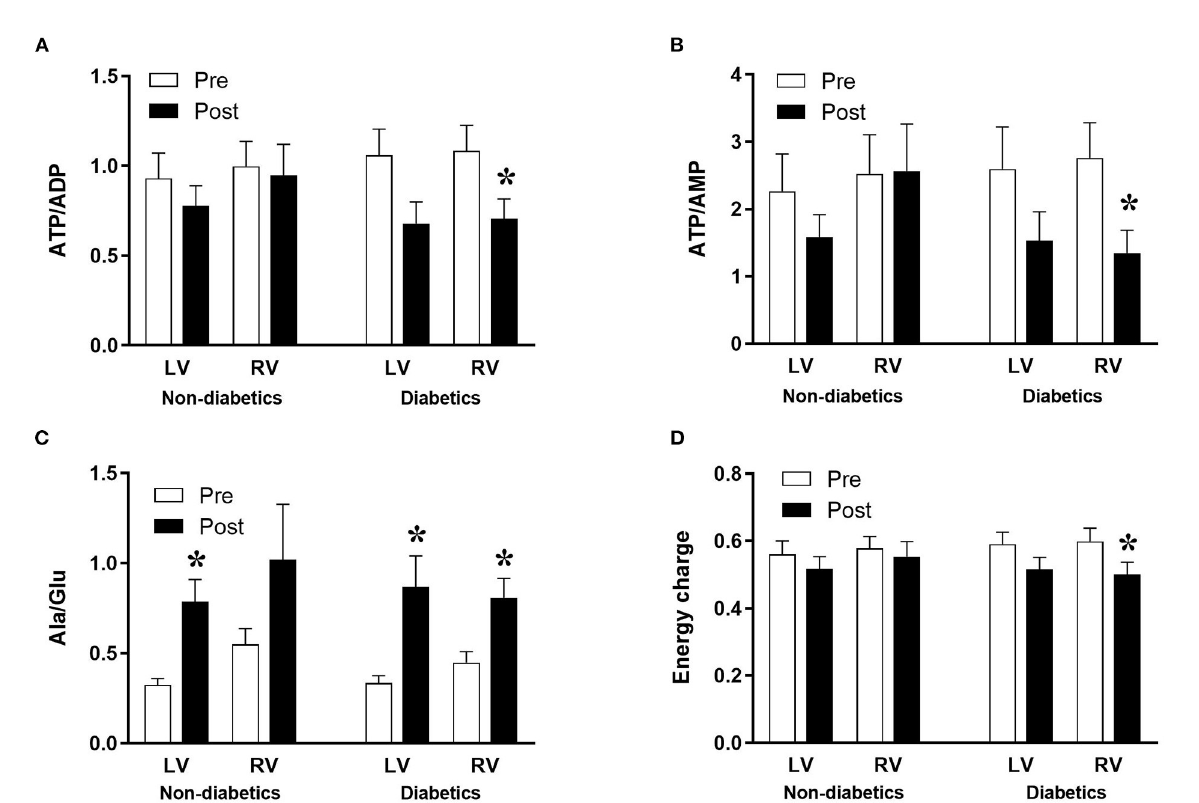
FIGURE2 Diabetes and metabolic ischemic stress during surgery in CABG patients. Values are mean ± SEM for ATP/ADP (A) , ATP/AMP (B) , Ala/Glu (C) , and Energy charge (D) in left (LV) and right (RV) ventricles of patients Pre- (white) and Post- (black) CABG surgery who are non-diabetic or diabetic. * Represents a significant difference vs. corresponding Pre samples (unpaired two-tailed student’s t -test or Mann-Whitney U -test as